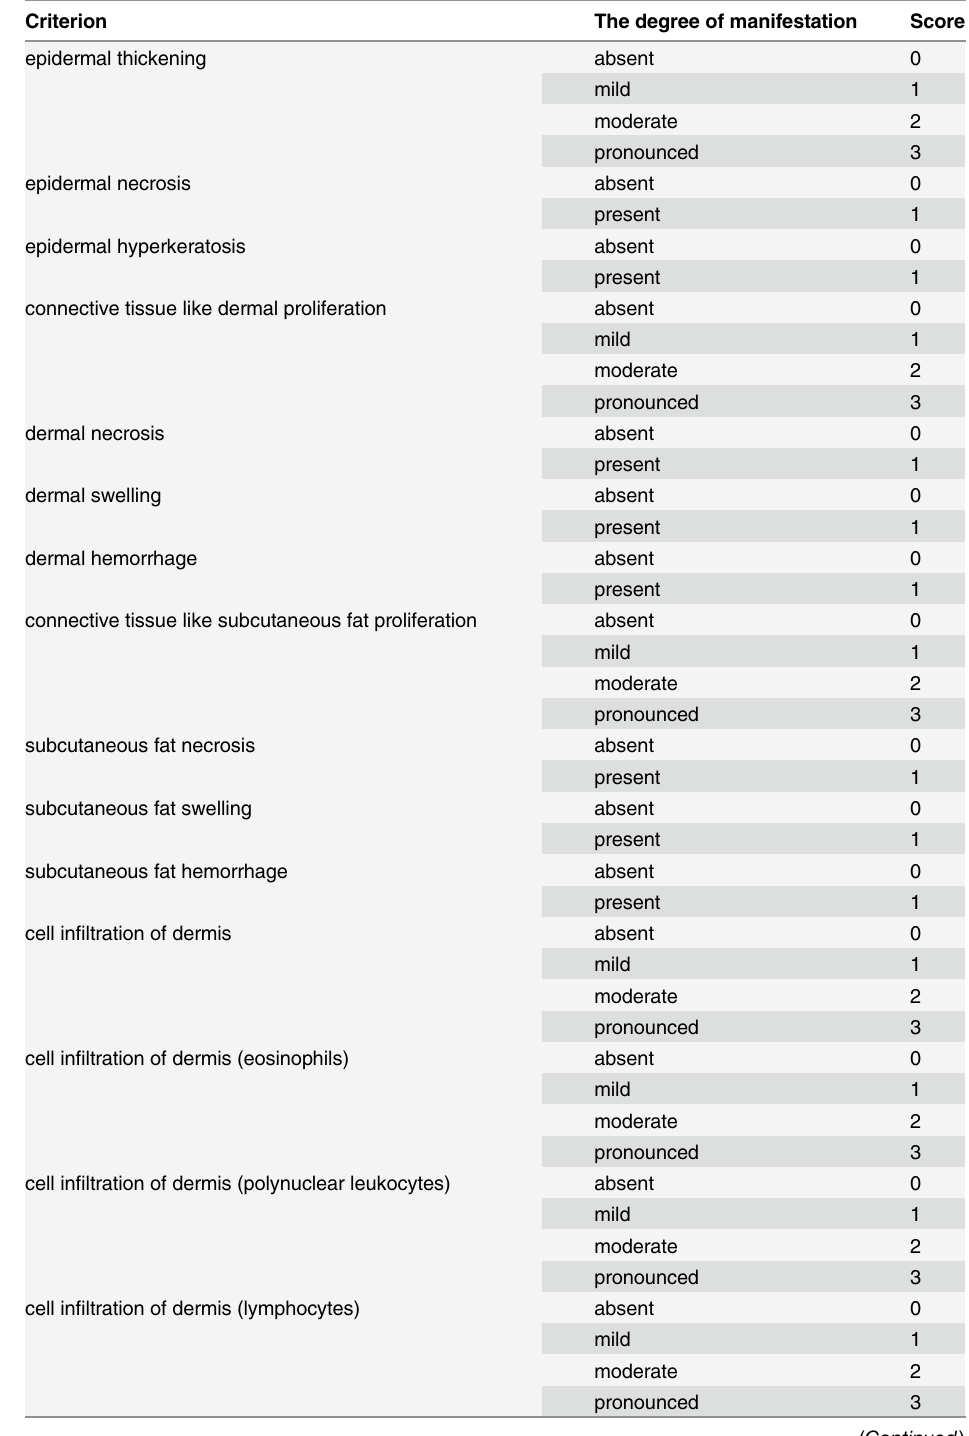
Table 1. The main assessment criteria for histologic skin